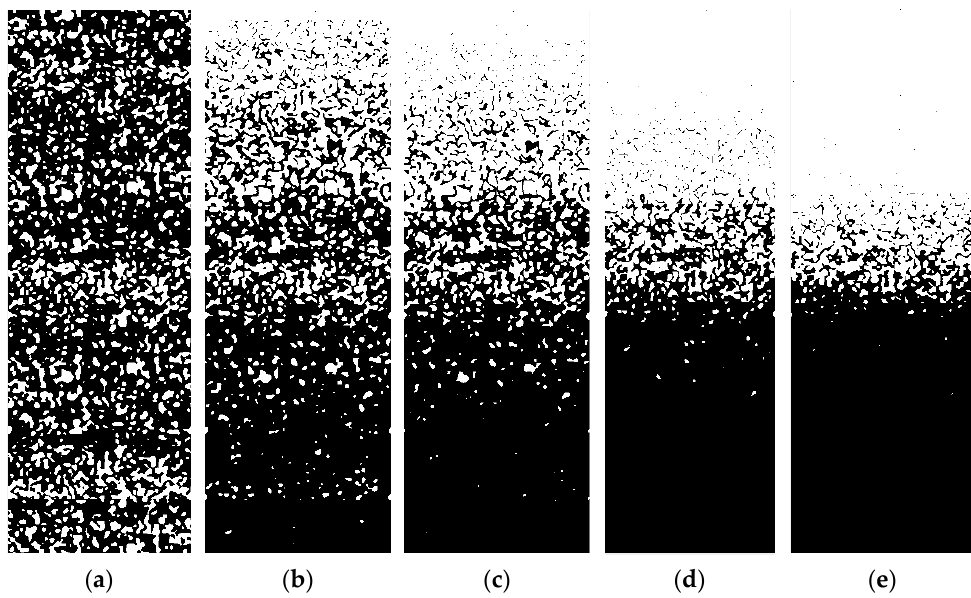
Figure 2. Establishment of the gradient model with ( a ) m = 0; ( b ) m = 1.0; ( c ) m = 2.0; ( d ) m = 5.0; ( e ) m = 10.0 ( c 0 = 1.0).